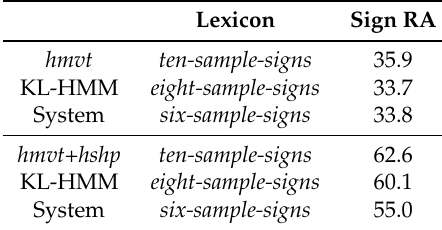
Table 12. Cross-lingual KL-HMM based hmvt and hmvt+hshp -based systems results on the DSGS database depending on the three different setups used to infer the lexicon ( ten-/eight-/six-sample-signs lexicon